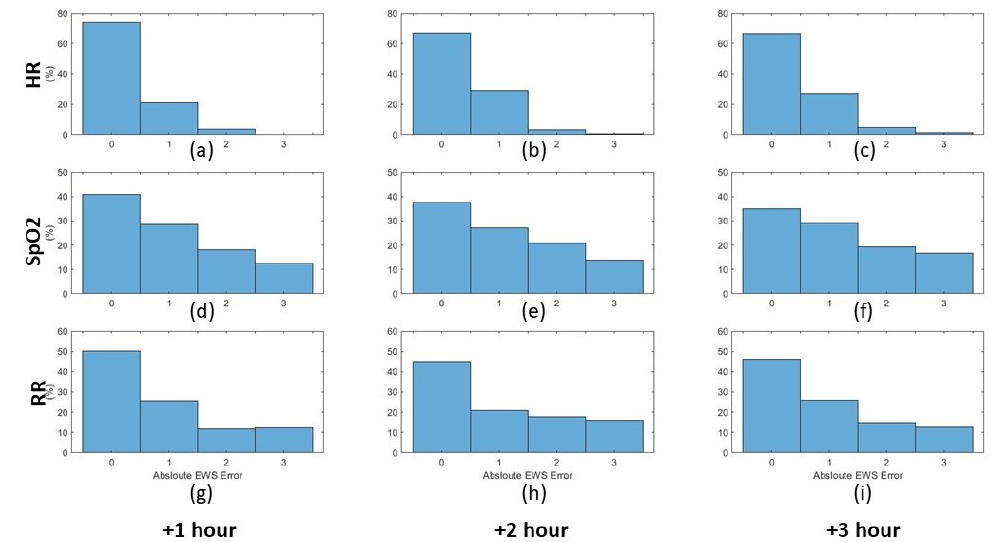
Figure 11. Normalised histograms of the absolute EWS error of the predicted values for the three vital signs for the upcoming three hours based on hourly to bi-hourly observations. Each row represents one of the three vital signs: heart rate, oxygen saturation, and respiration rate, respectively. Each column represents the prediction hour: +1, +2, +3 h, respectively. ( a ) HR +1 h, ( b ) HR +2 h, ( c ) HR